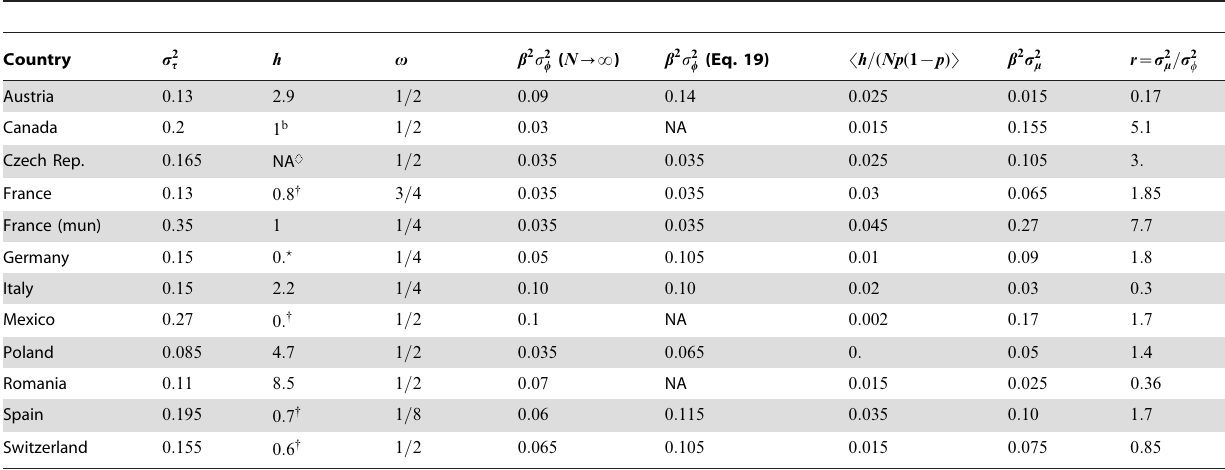
Table 7. Decomposition of the total LTR variance into a cultural field component b 2 s 2 binomial component, S h = ( Np (1 { p ) T , corrected by a herding coefficient h § 1 .